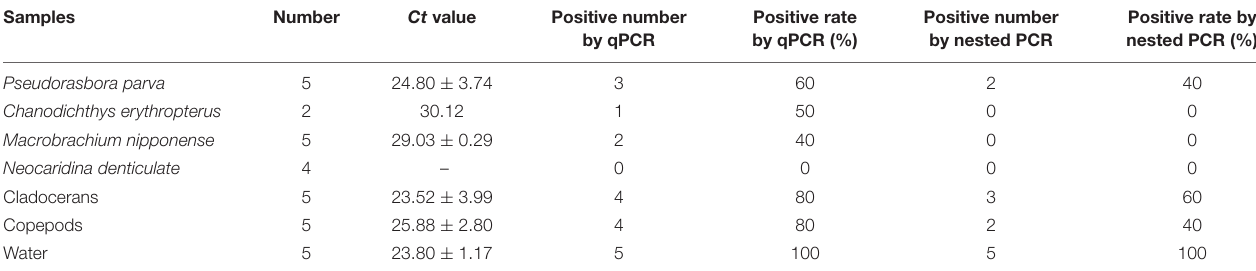
TABLE 4 | Detection rate of EAM in samples from rice field of infected P. sinensis by qPCR and nested PCR.